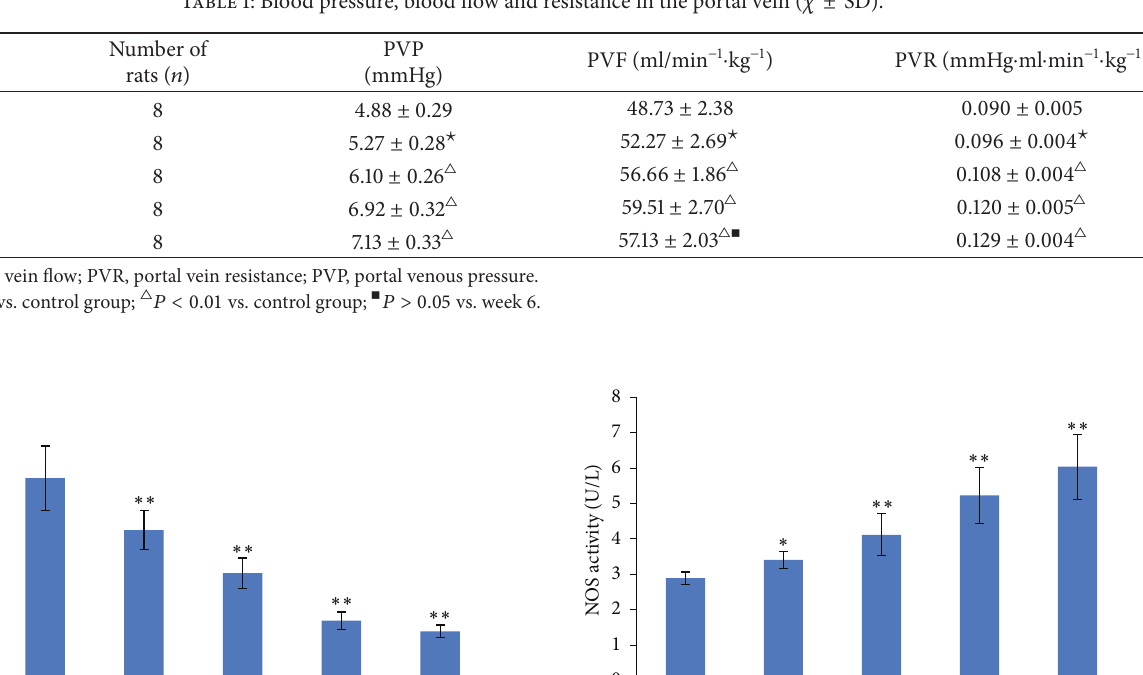
Table 1: Blood pressure, blood flow and resistance in the portal vein ( 𝜒 ± SD).